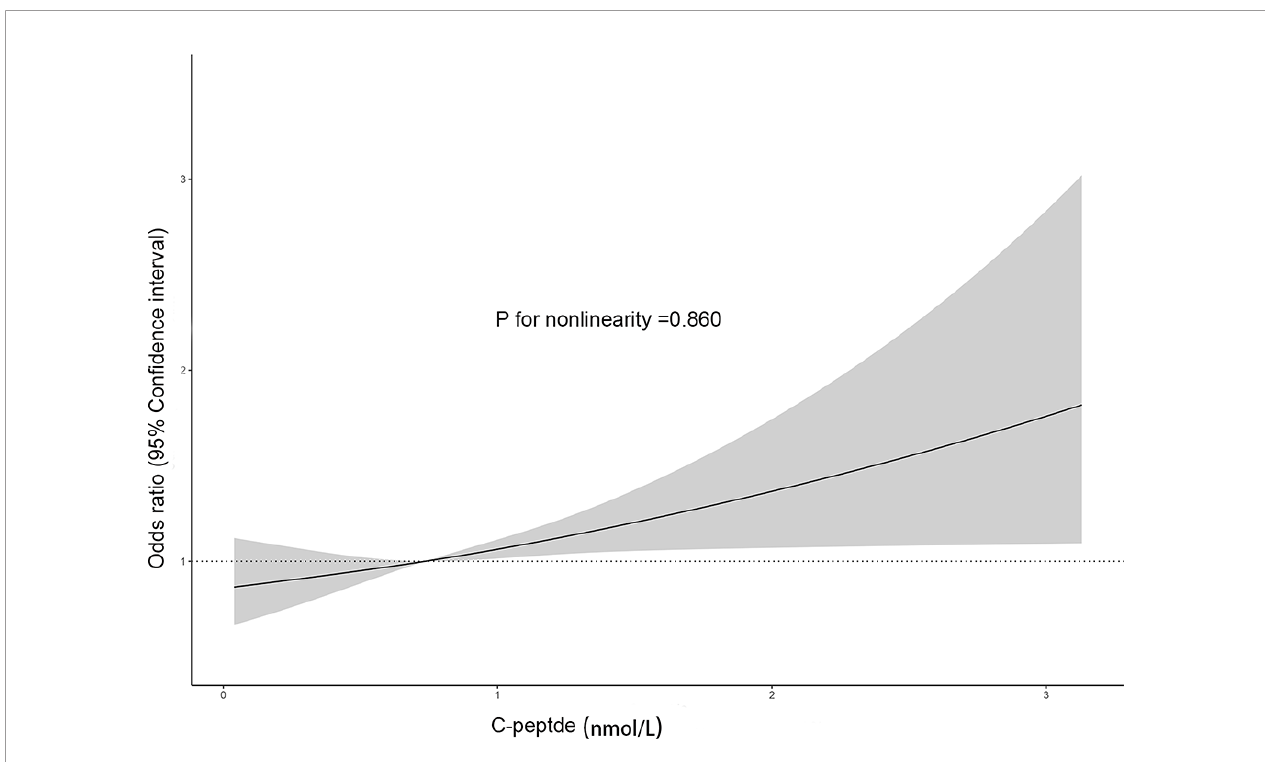
FIGURE 2 | The dose – response relation between C-peptide and SC-MI.